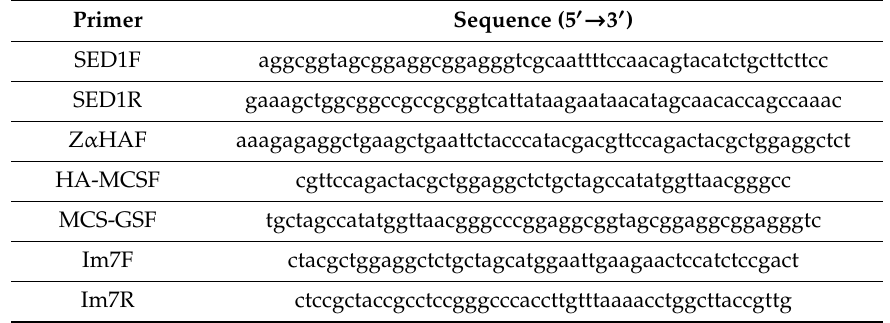
Table 4. The primers used for the construction of plasmids pPICZ α A-HA-SED1 and pPICZ α A-HA-Im7-SED1.